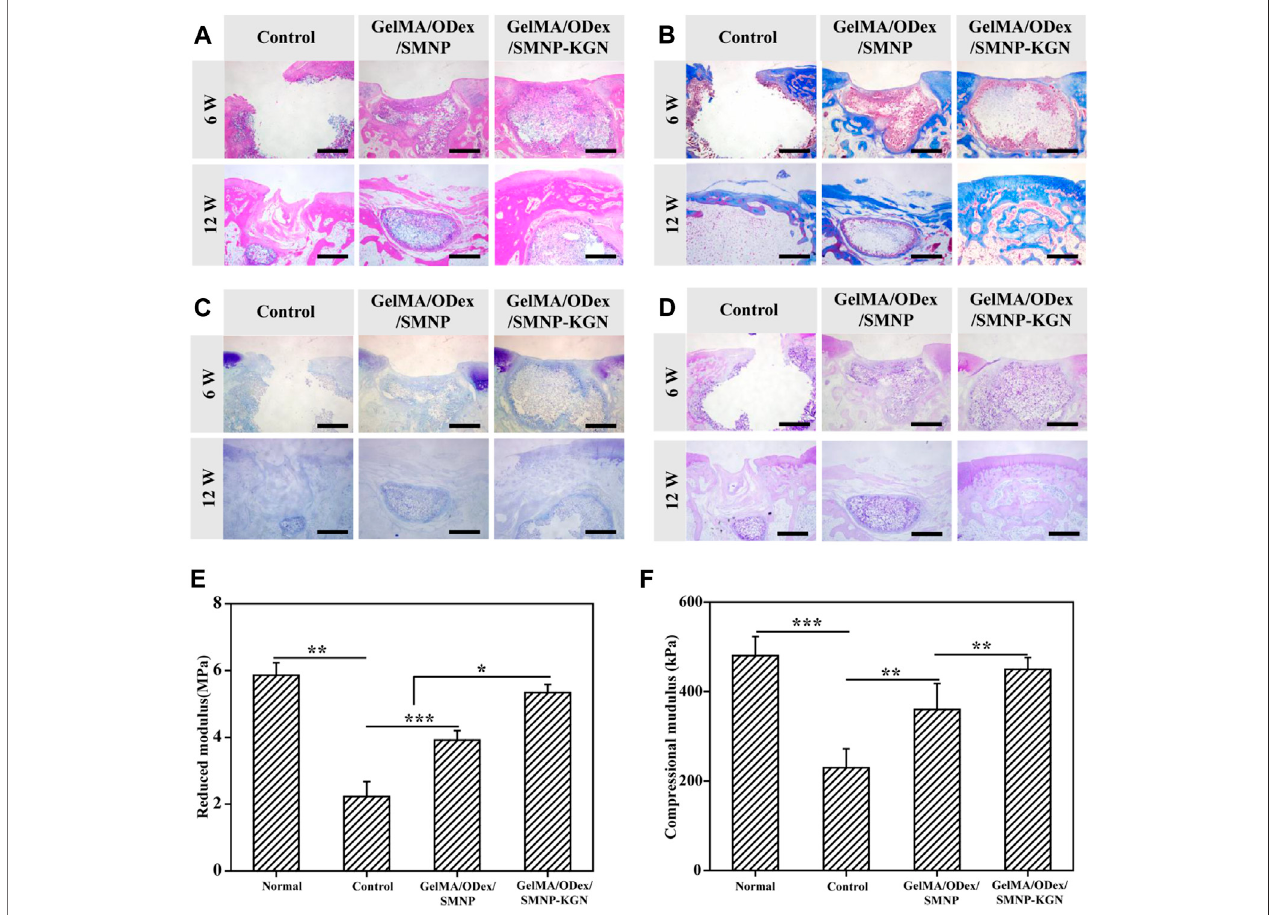
FIGURE7| Evaluationoftheeffectofcartilageregeneration invivo . (A) H&E, (B) Masson, (C) toluidine, and (D) PASstainingofdefect cartilage at 6and 12 weeks. Scale bar = 200 μ m. (E) Reduced modulus and (F) compressional modulus of regenerated cartilage in 12 weeks.